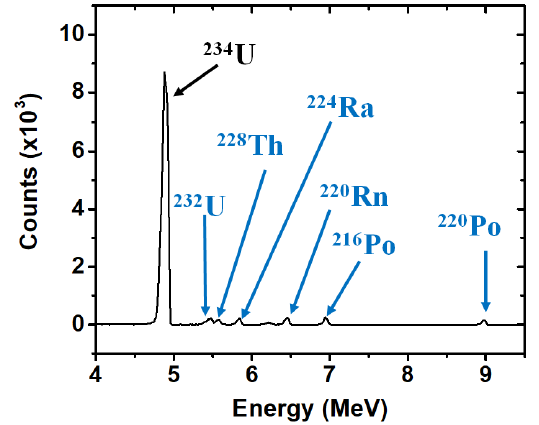
Figure 1. A typical spectrum of α -particles obtained from the 234 U sample. The origin of each α -peak is marked and the im- purities were found to be much less than 1% of the total active mass.